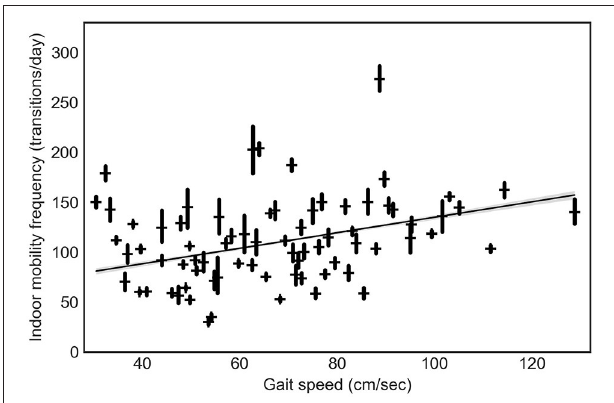
FIGURE 2 | The relationship between indoor mobility frequency and gait speed.